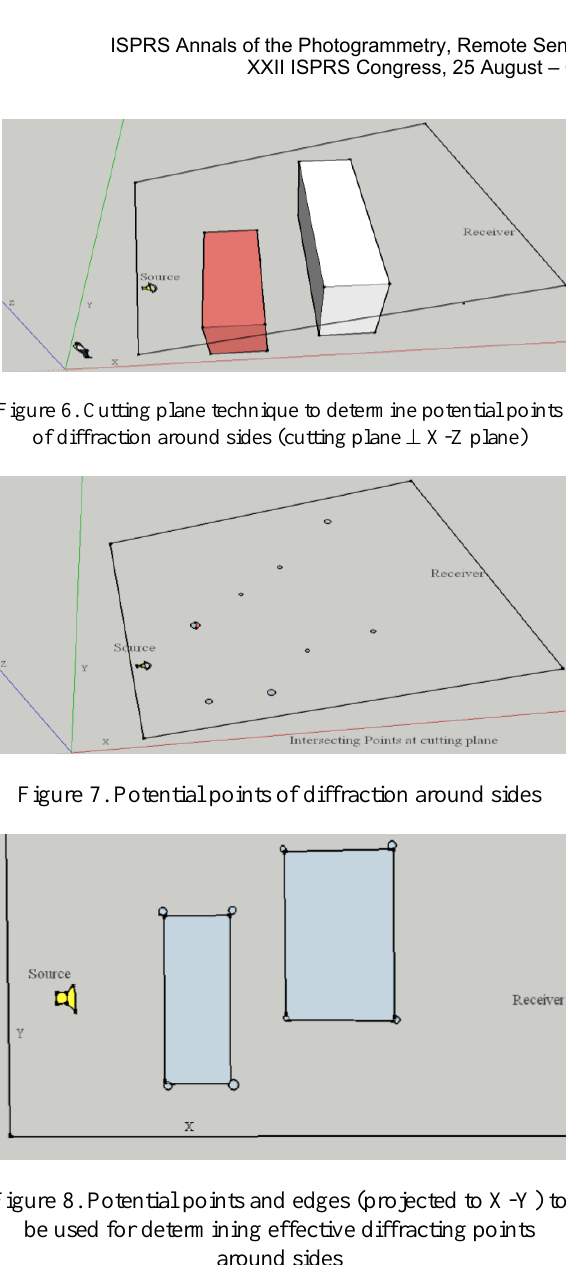
Figure 10. Determination of ground reflecting point .